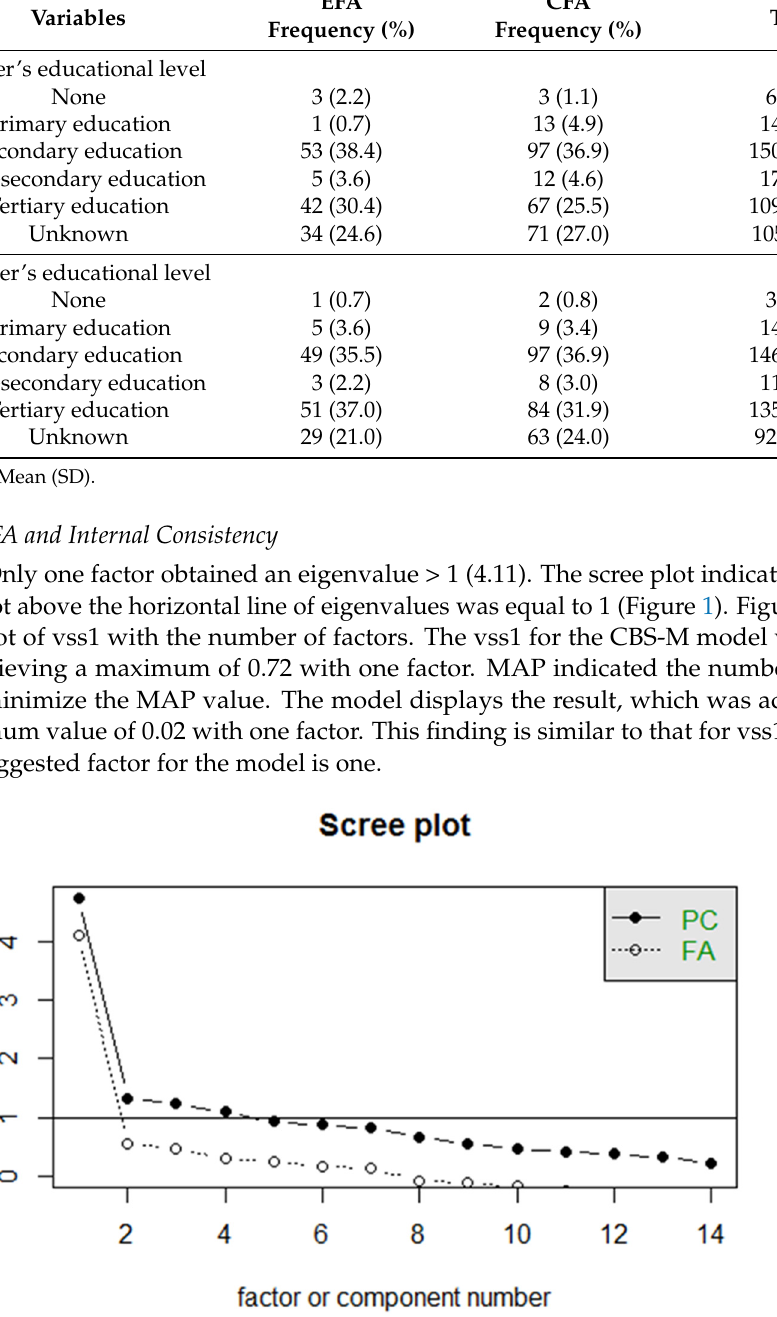
Figure 1. Scree plot of the Cyberbullying Scale-Malay (CBS-M) model. (PC: Principal Components, FA: Factor Analysis).